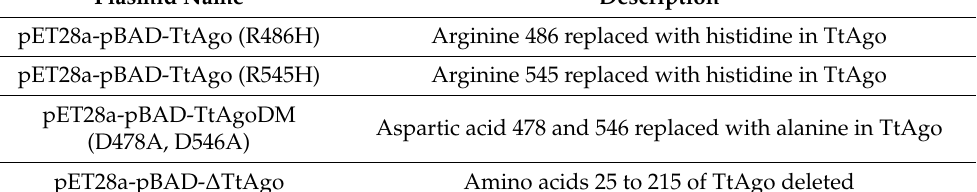
Table 2. Plasmids used and presented in Figures 8 and